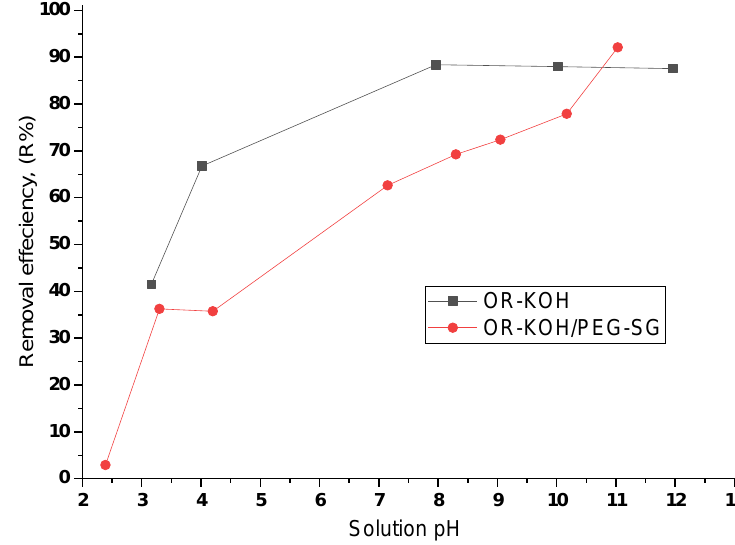
Figure 3. Effect of pH on MB adsorption onto OR-KOH and OR-KOH/PEG-SG adsorbents.